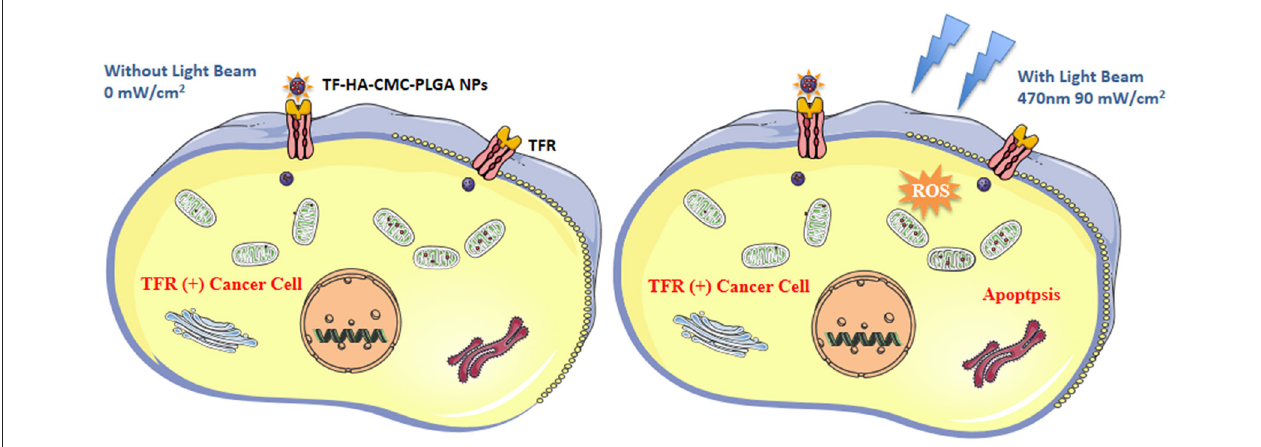
FIGURE 11 | Schematic diagram of the mechanism of apoptosis induced by TF-HA-CMC-PLGA NPs. TF-HA-CMC-PLGA NPs enter TFR positive cancer cells depend on TFR recognized the TF on the surface of TF-HA-CMC-PLGA NPs (Left and right) . The photosensitizers won’t produce ROS when the light illumination was not performed (Left) . ROS were produced by photosensitizers inside cells only under light illumination. Excess ROS caused cancer cells apoptosis and inhibited tumor growth (Right)